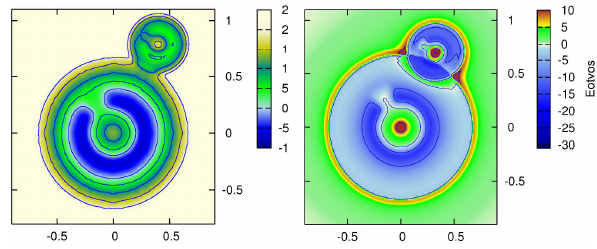
Fig. 12. (a)–(b) Gravity anomalies (left) and the second radial derivatives, T rr , (right), of Popigai and its possible nearest compan- ion (in mGal and E, respectively) as derived from the craters model. To be comparable with EGM2008 (see Figs. 2 and 3), the mod- els were smoothed to the EGM2008 resolution. Coordinate axes, λ cos ϕ and ϕ are in degrees.